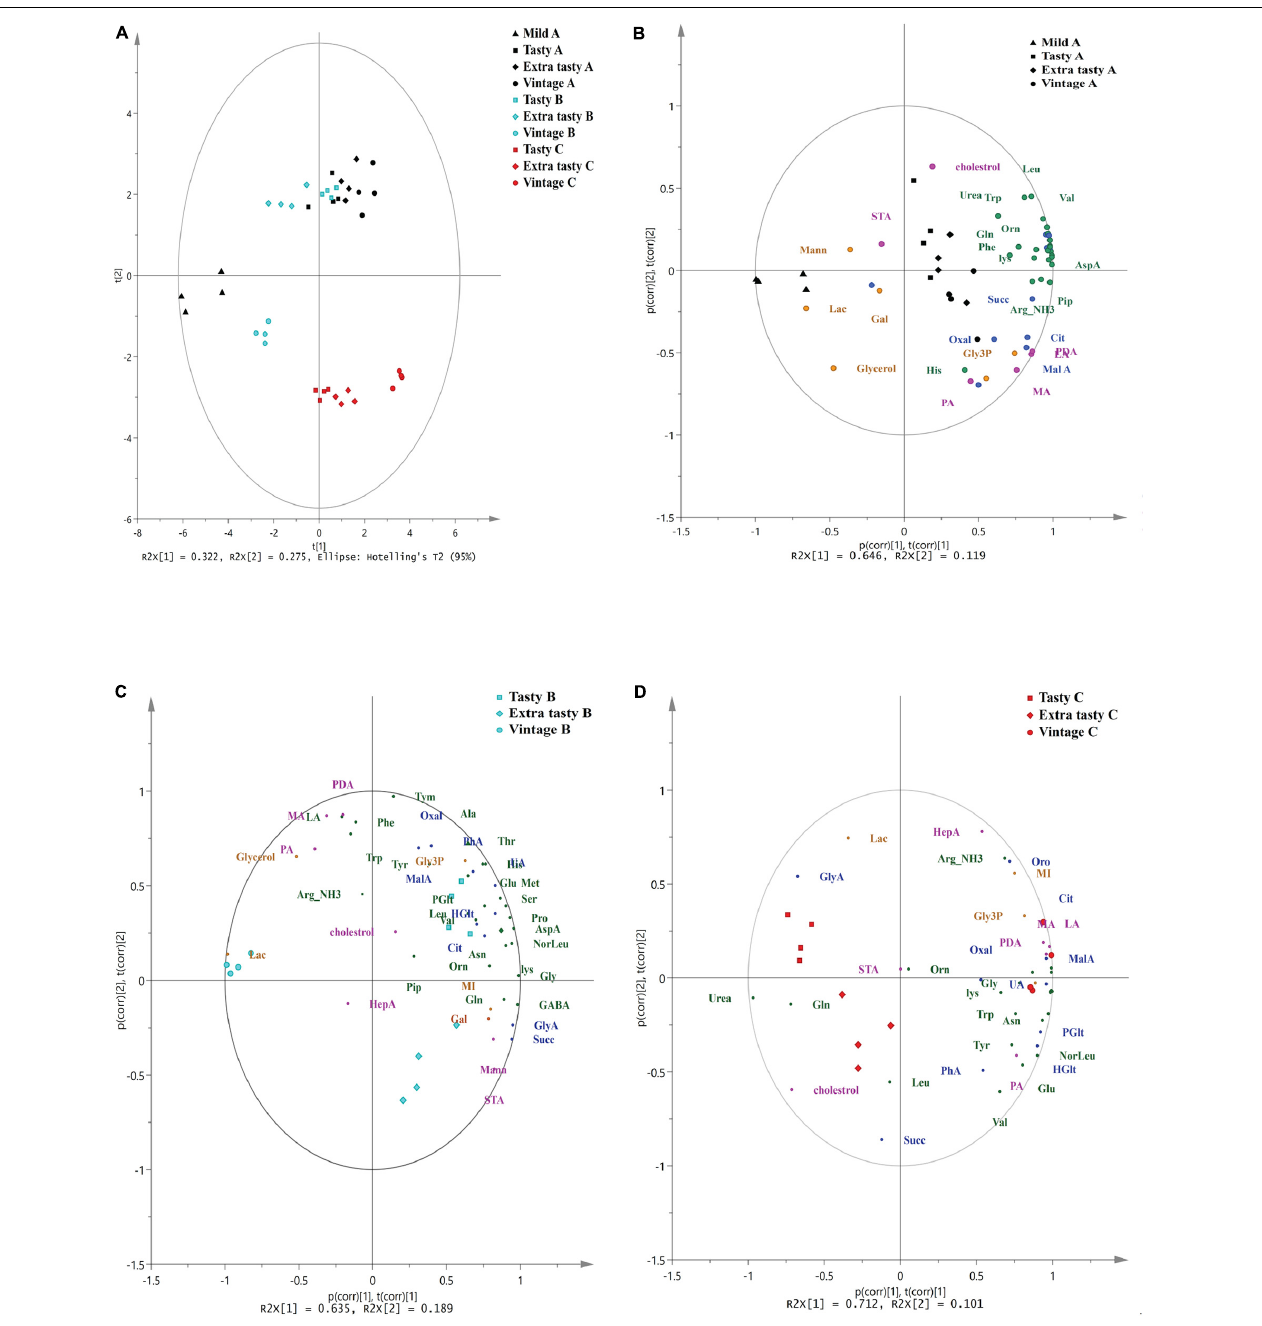
FIGURE 3 | Principal Component Analysis (PCA) of untargeted GC/MS metabolomics of cheeses made by different manufacturers. (A) PCA of untargeted GC/MS metabolomics of cheeses made by different manufacturers. PC1 and PC2 account for 32.2% and 27.5% of the variance, respectively. (B–D) The biplot superimposed on the scores and loadings of PCA analysis based on a correlation scaling method for cheeses for brand A (B) , brand B (C) , and brand C (D) Brands and maturity of cheeses are as indicated. p(corr), t(corr) is a combined vector, p(corr) represents loading p scaled as correlation coefficient between X and t; t(corr) represents score t scaled as correlation coefficient resulting in all points falling inside the circle with radius 1. Different colors represent different brands and different classes of metabolites: black; brand A, cyan; brand B, red; brand C, green; amino acids and amines, blue; carboxylic acids, pink; fatty acids and sterols, orange; sugar and sugar phosphates. Orn, ornithine; Tyr, tyrosine; GABA, gamma amino butyric acid; Lys, lysine; Gly, glycine; Val, valine; Ser: serine; Leu, leucine; Noreleu, noreleucine; Thr, threonine; Pro, proline; Pip, piperedine; Asn, asparagine; AspA, aspartic acid; Glu, glutamic acid; Met, methionine; Arg, arginine; PDA, pentadecanoic acid; HepA, heptadecanoic acid; LA, lauric acid (dodecanoic acid); PA, palmitic acid (hexadecanoic acid); STA, stearic acid (octadecanoic acid); MA, myristic acid (tetradecanoic acid); Oxal, oxalic acid; Succ, succinic acid; GlyA, glyceric acid; Glt, glutaric acid; MalA, malonic acid; HGlt, hydroxy-glutaric acid; Citric, citric acid; GalA, galactonic acid, Pglu, pyroglutamic acid; Oro, orotic acid; UA, uric acid; PhA, phosphoric acid; Mann, mannose; Gal, galactose; MI, inositol myo; Lac, lactose; Gly3p, glycerol-3-phosphate.